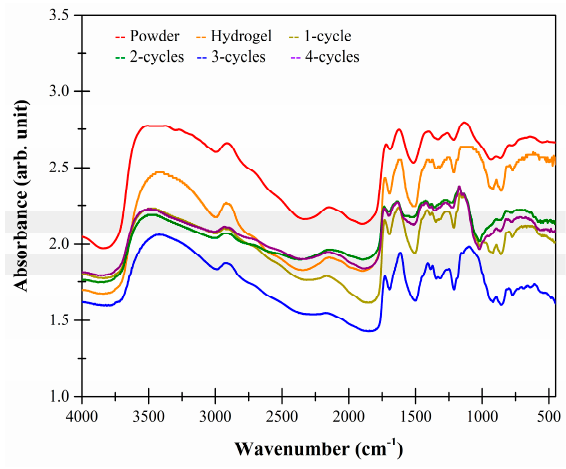
Figure 6 Figure 6. FTIR spectra of xanthan powder, hydro- and cryogels.